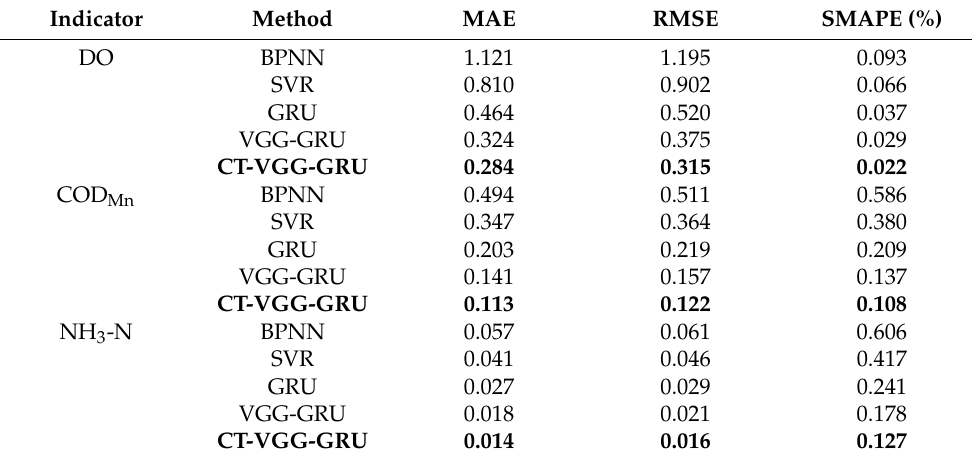
Table 5. Comparison of model performance. The best experimental results of the CT-VGG-GRU model are highlighted in